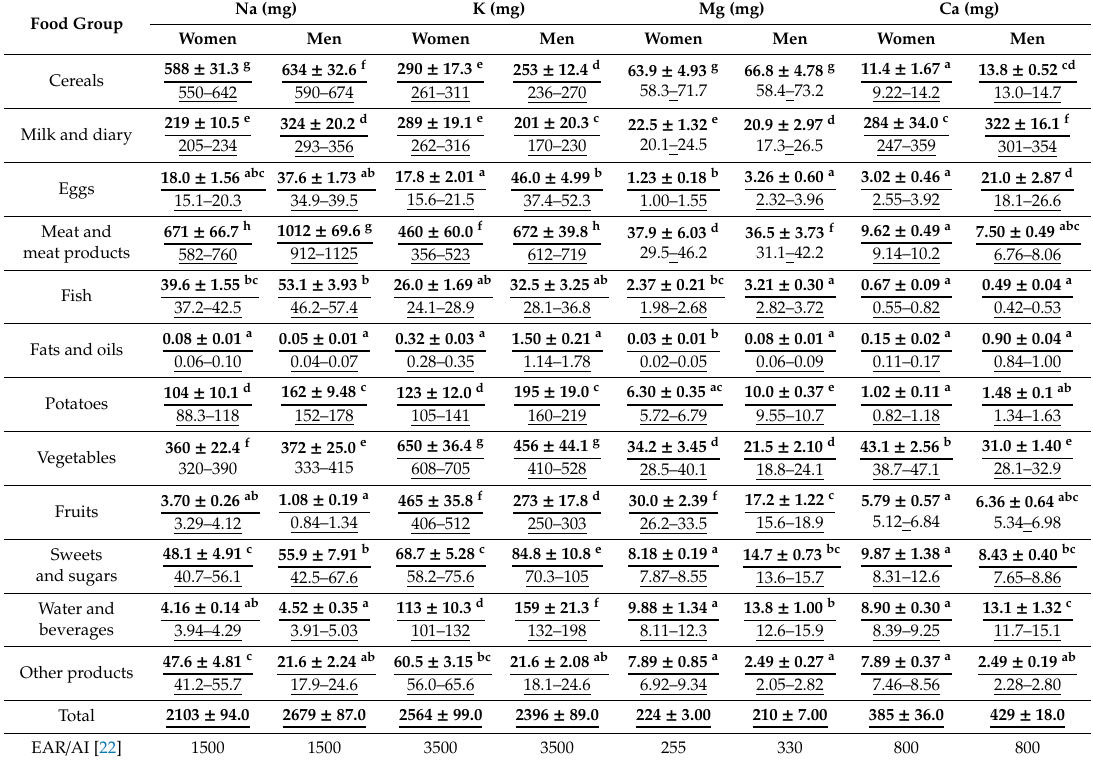
Table 4. Daily intake of macroelements with particular food groups. Each value represents mean ± SD. Means not sharing the same letter in a column are significantly di ff erent at p ≤ 0.05. Means underlined are significantly di ff erent between women and men at p ≤